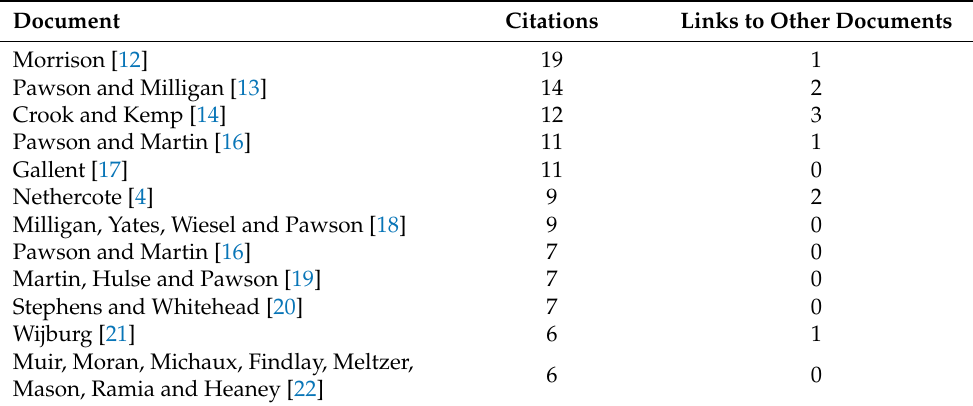
Table 6. Authors’ analysis of the retrieved articles.